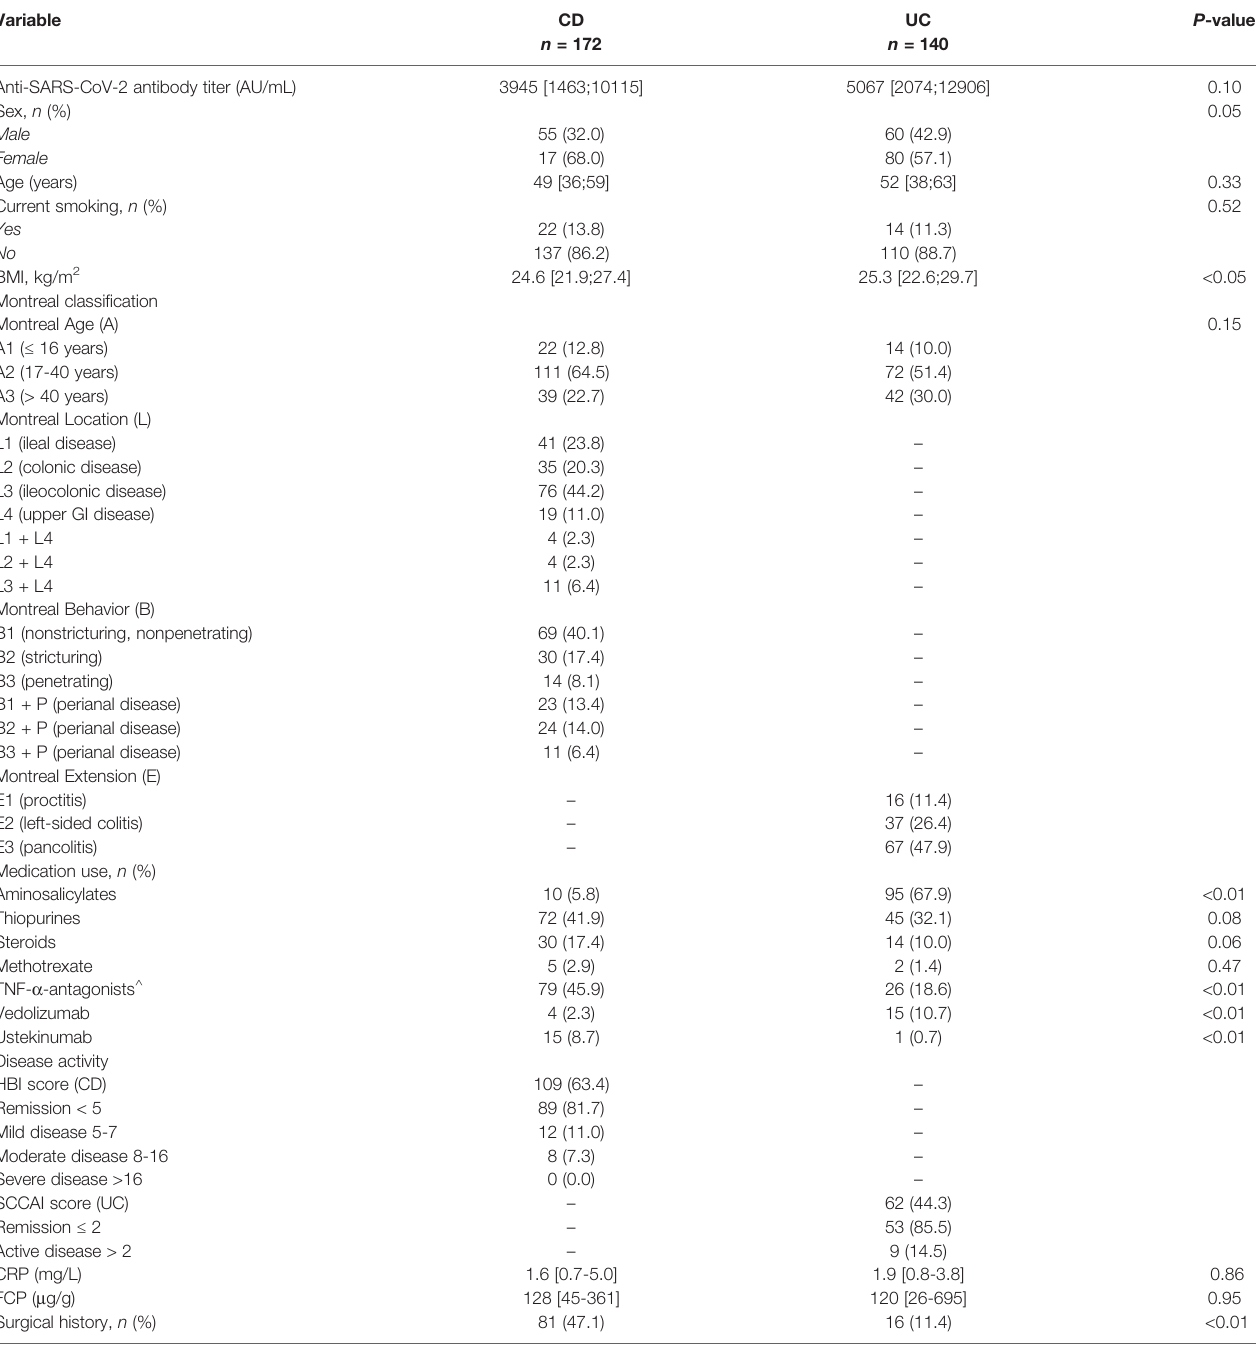
TABLE 1 | Demographic and clinical characteristics of the study population.